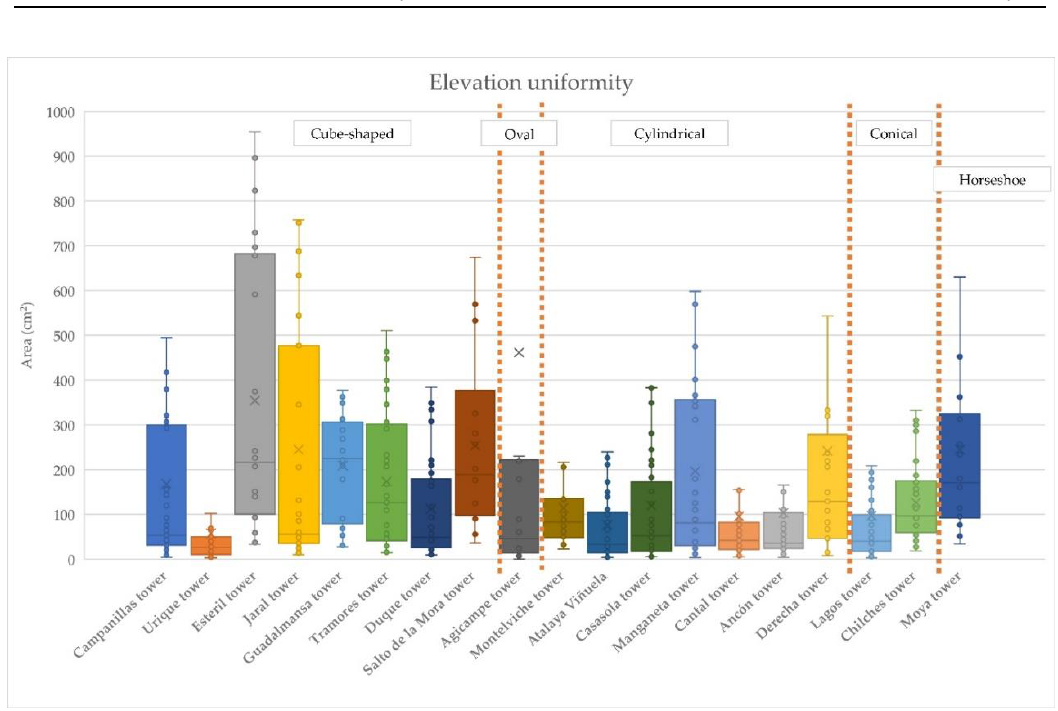
Figure 13. Graph showing the percentage of masonry in each elevation and possible classification of construction systems according to the ratio of materials in masonry constructions.